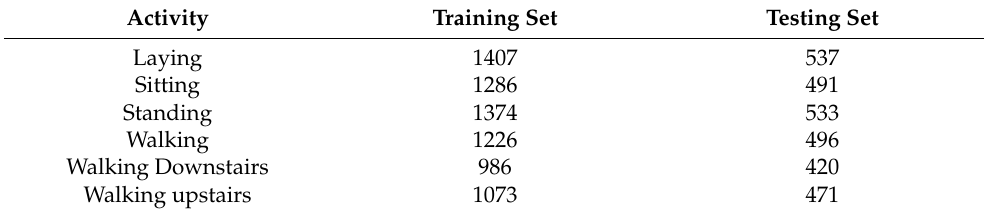
Table 1. Dataset size for each human activity.